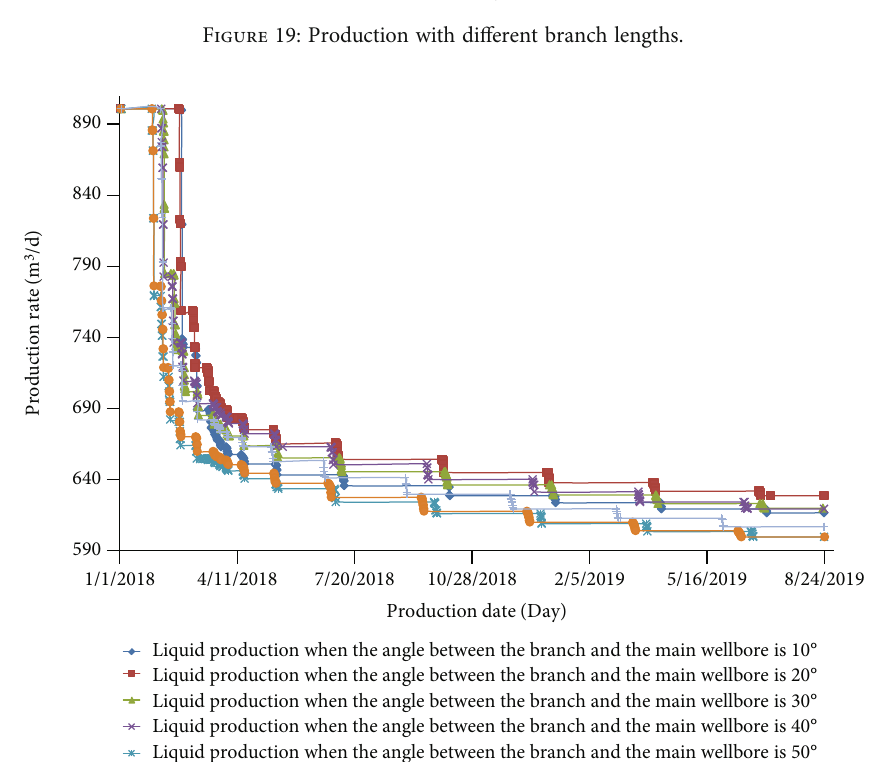
Figure 20: Production with di ff erent angles between the branch and main well